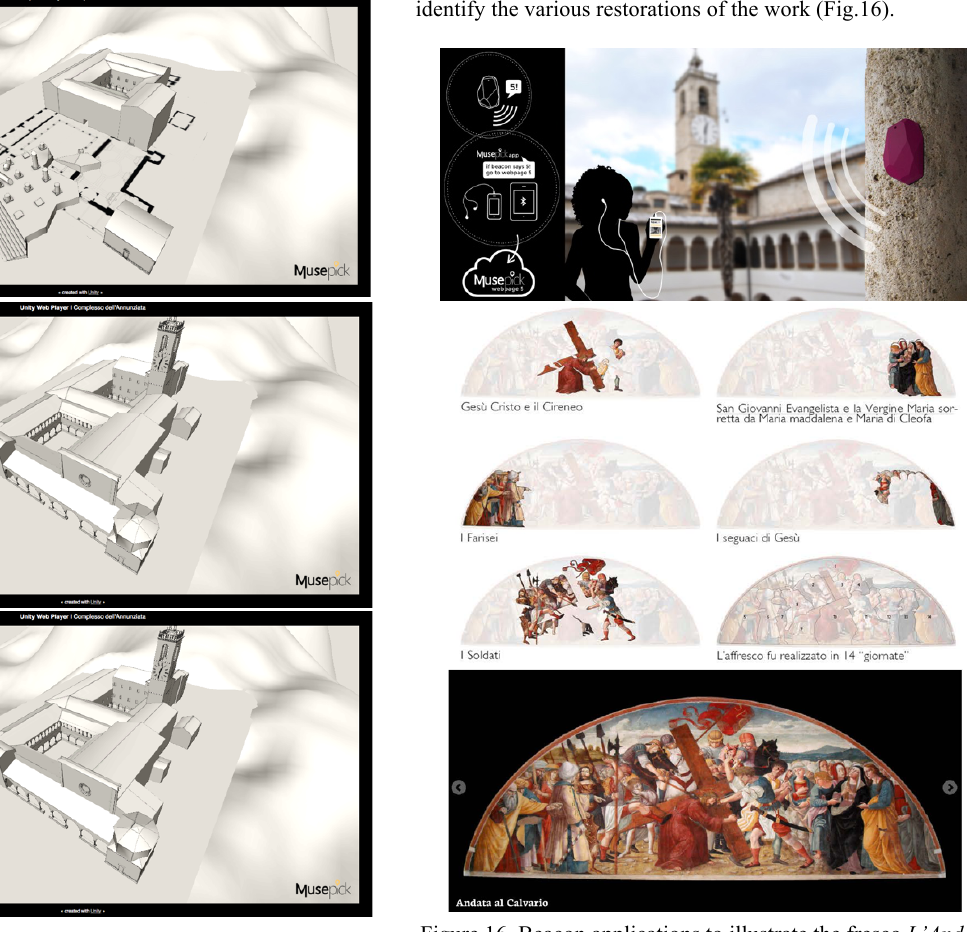
Figure 15. Interface of the immersive walkthrough application elaborated with Unity 3D render engine